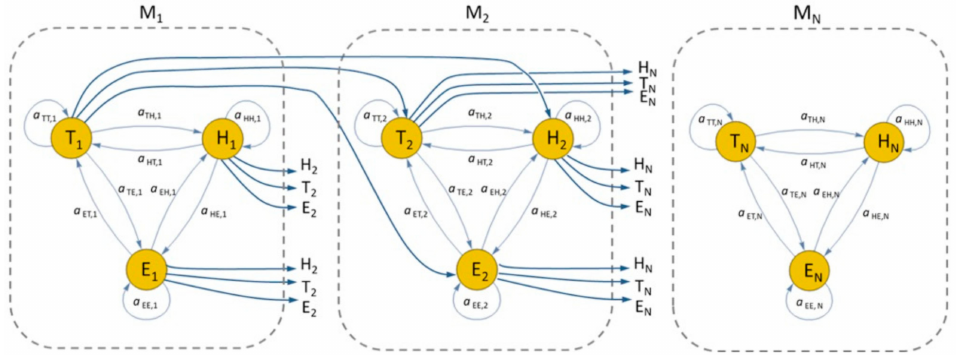
Figure 3. State diagram of the suggested hierarchical HMM, able to model the temporal dependency of daily